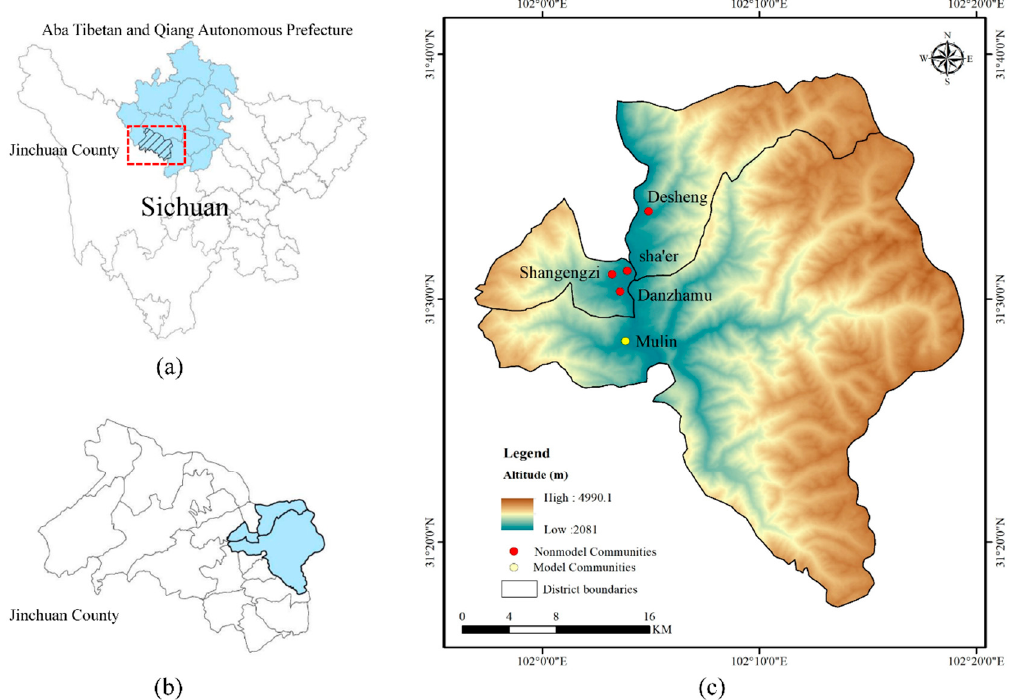
Figure 2. Site location of the study area. ( a ) Administrative map of Sichuan Province. ( b ) Jinchuan County administrative map and survey of townships. ( c ) Distribution of field survey sites.